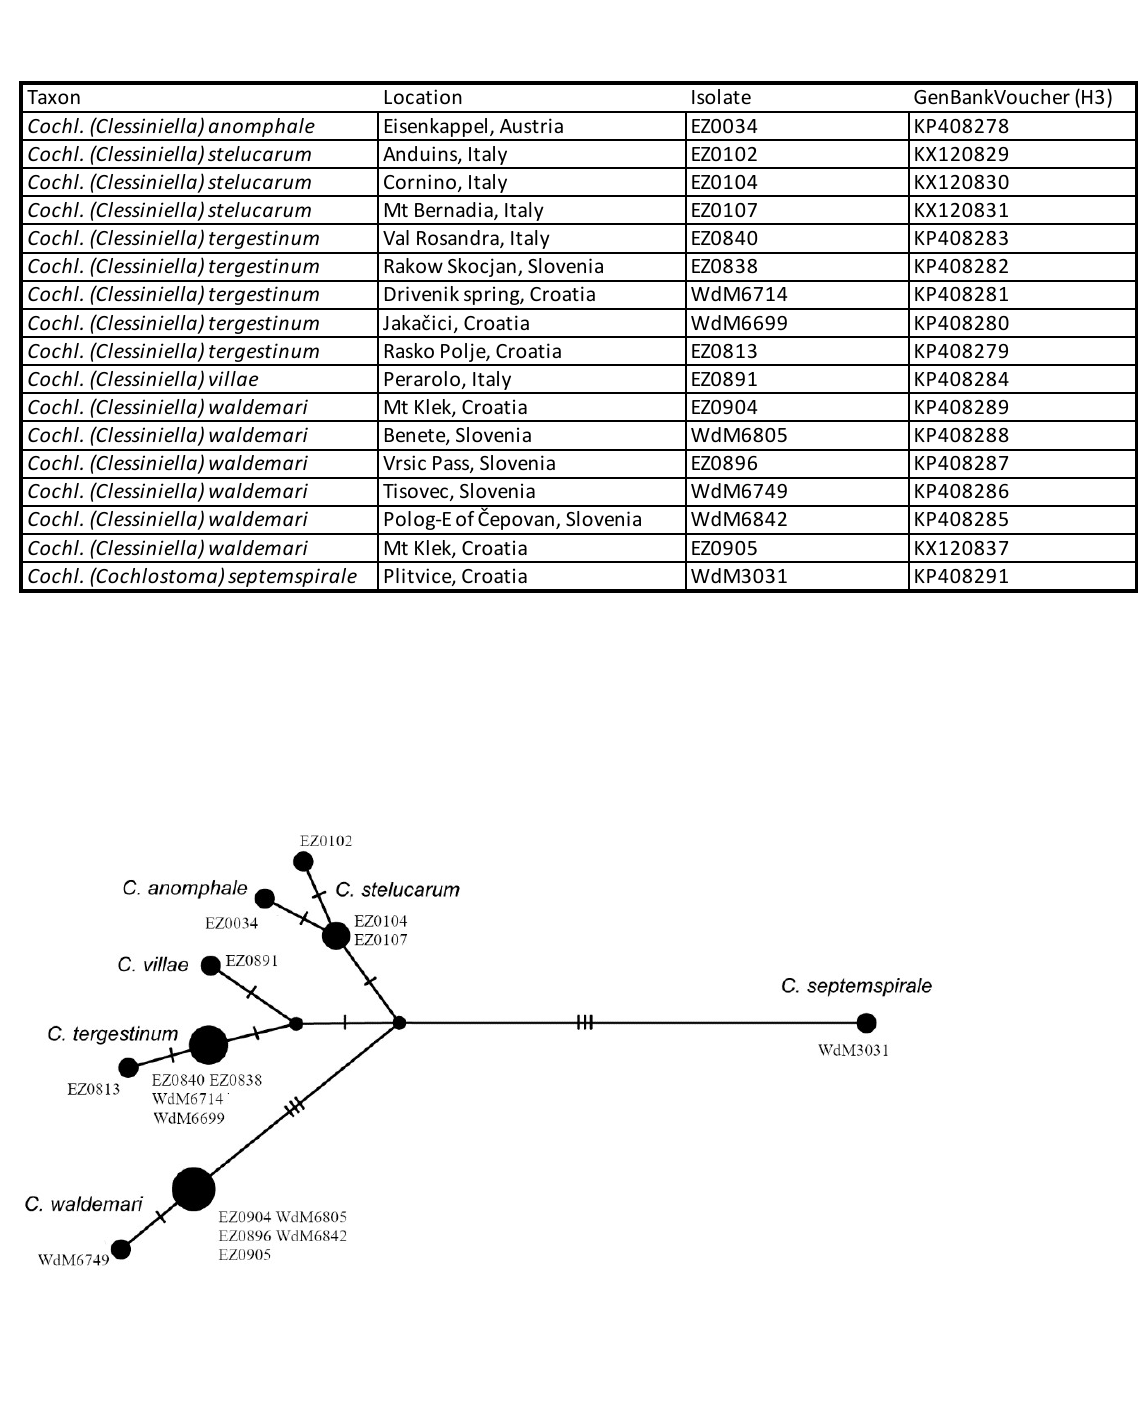
Table 5. GenBank voucher (H3).